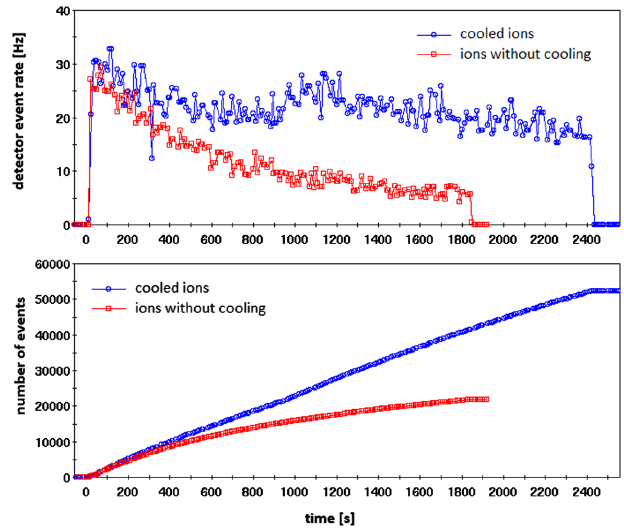
FIG. 8. Event rate (top plot) and number of accumulated events registered by RHIC detector (bottom plot) for cooled (blue line) and not cooled (red line) stores.